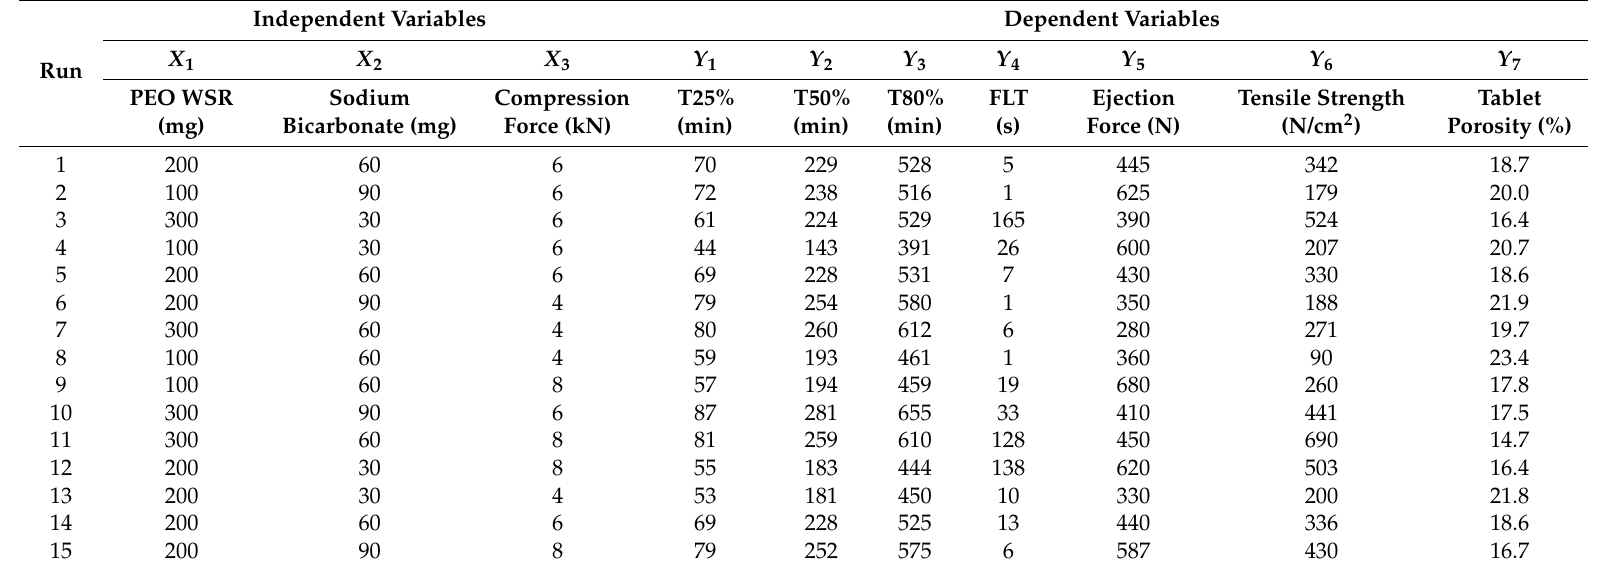
Table 1. Box Behnken experimental design with three independent variables (control factors), and dependent variables of drug release at different time points, floating lag time, tablet ejection force, tablet tensile strength, and tablet